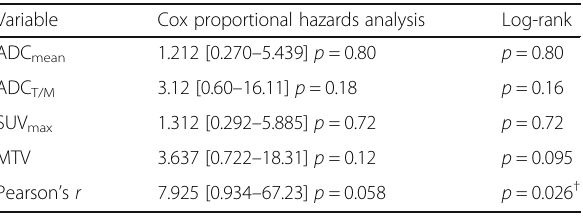
Table 3 Univariate Cox proportional hazards analysis and log-rank analysis for DFS for the imaging metrics investigated. Variables were treated as categorical, dichotomized by the median for each imaging metric